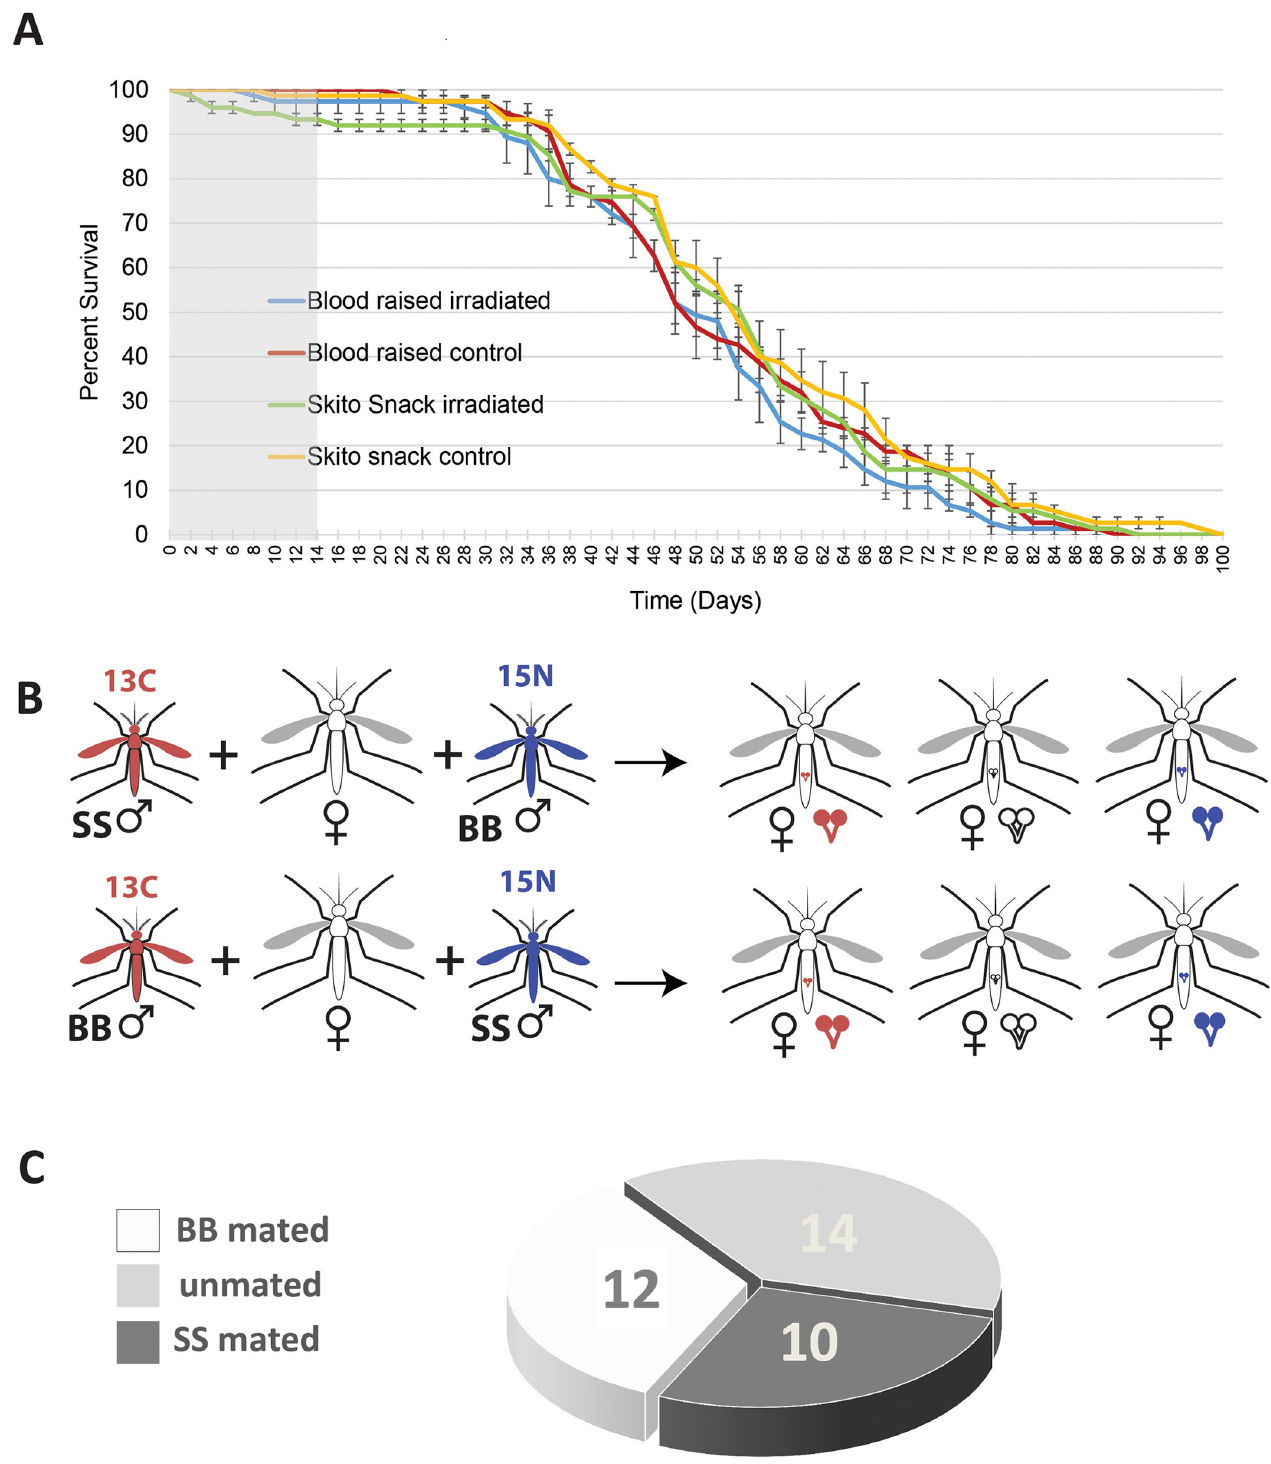
Fig 5. Fitness of SkitoSnack-raised mosquito males compared to bovine blood-raised males. (A) Survival curve of mosquito males from SkitoSnack culture and bovine blood culture with and without radiation treatment. The grey box marks the first fourteen days after the start of the experiment that were analyzed as an individual dataset. (B) Experimental setup scheme for the mating competition assay. To avoid a labeling bias, males from both diet groups, SkitoSnack (SS), and bovine blood (BB) were labeled with each stable isotope. On the right side, the three different outcomes we observed are shown. Half of the matings were set up as shown in the upper panel, the other half were set up as shown in the lower panel. (C) Paternity test results. Shown is the number of females that mated with a male from a specific diet group and the number of females that did not mate. No double matings were observed. https://doi.org/10.1371/journal.pntd.0008591.g005 PLOS NeglectedTropical Diseases | https://doi.org/10.1371/journal.pntd.0008591 September 17,